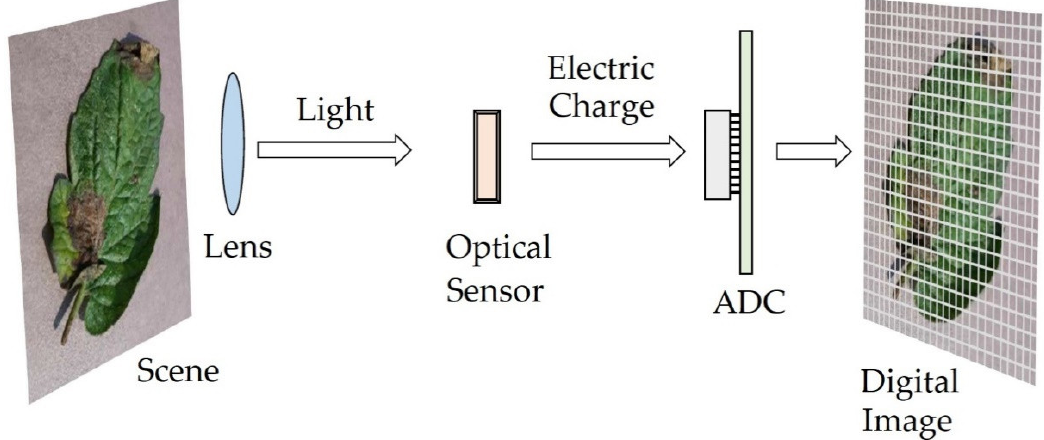
Figure 1. Image acquisition.